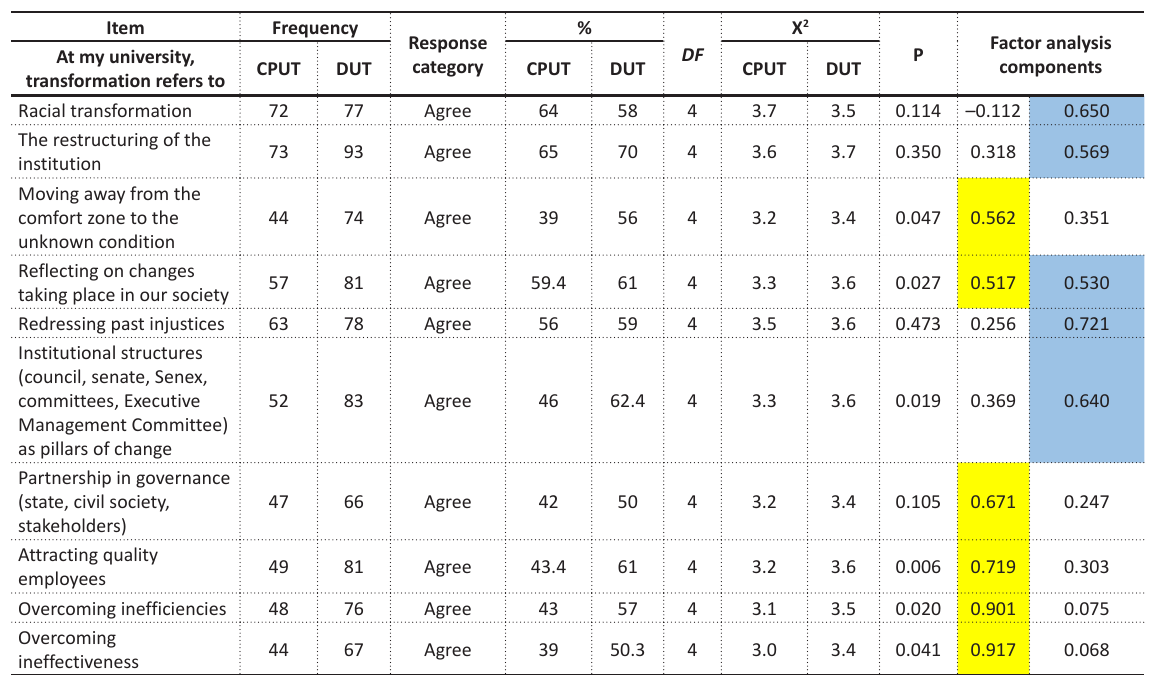
Table 2. Knowledgeability of